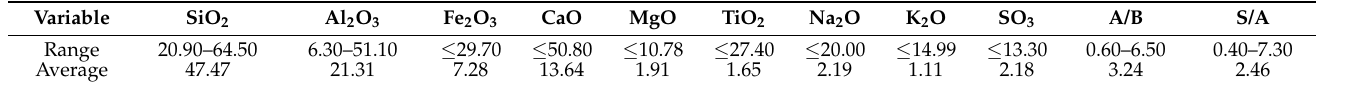
Table 1. Chemical composition of glassy slag (inorganic component